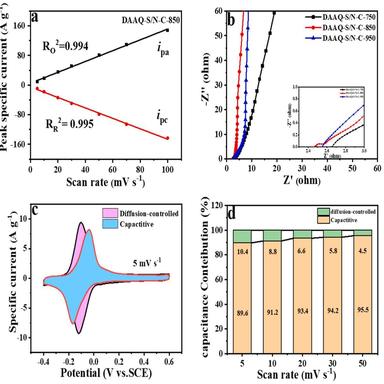
(a) The log i versus log ν plot of the redox peaks currents. (b) Nyquist plots with a magnified high-frequency region as an inset. (c) Deconvolution of the contribution from capacitive and diffusion-controlled charge storage processes for the DAAQ-S/N-C-850 electrode at 5 mV s − 1 . (d) Capacitance contribution of capacitive and diffusion-controlled charge storage processes from 5 to 50 mV s − 1 .